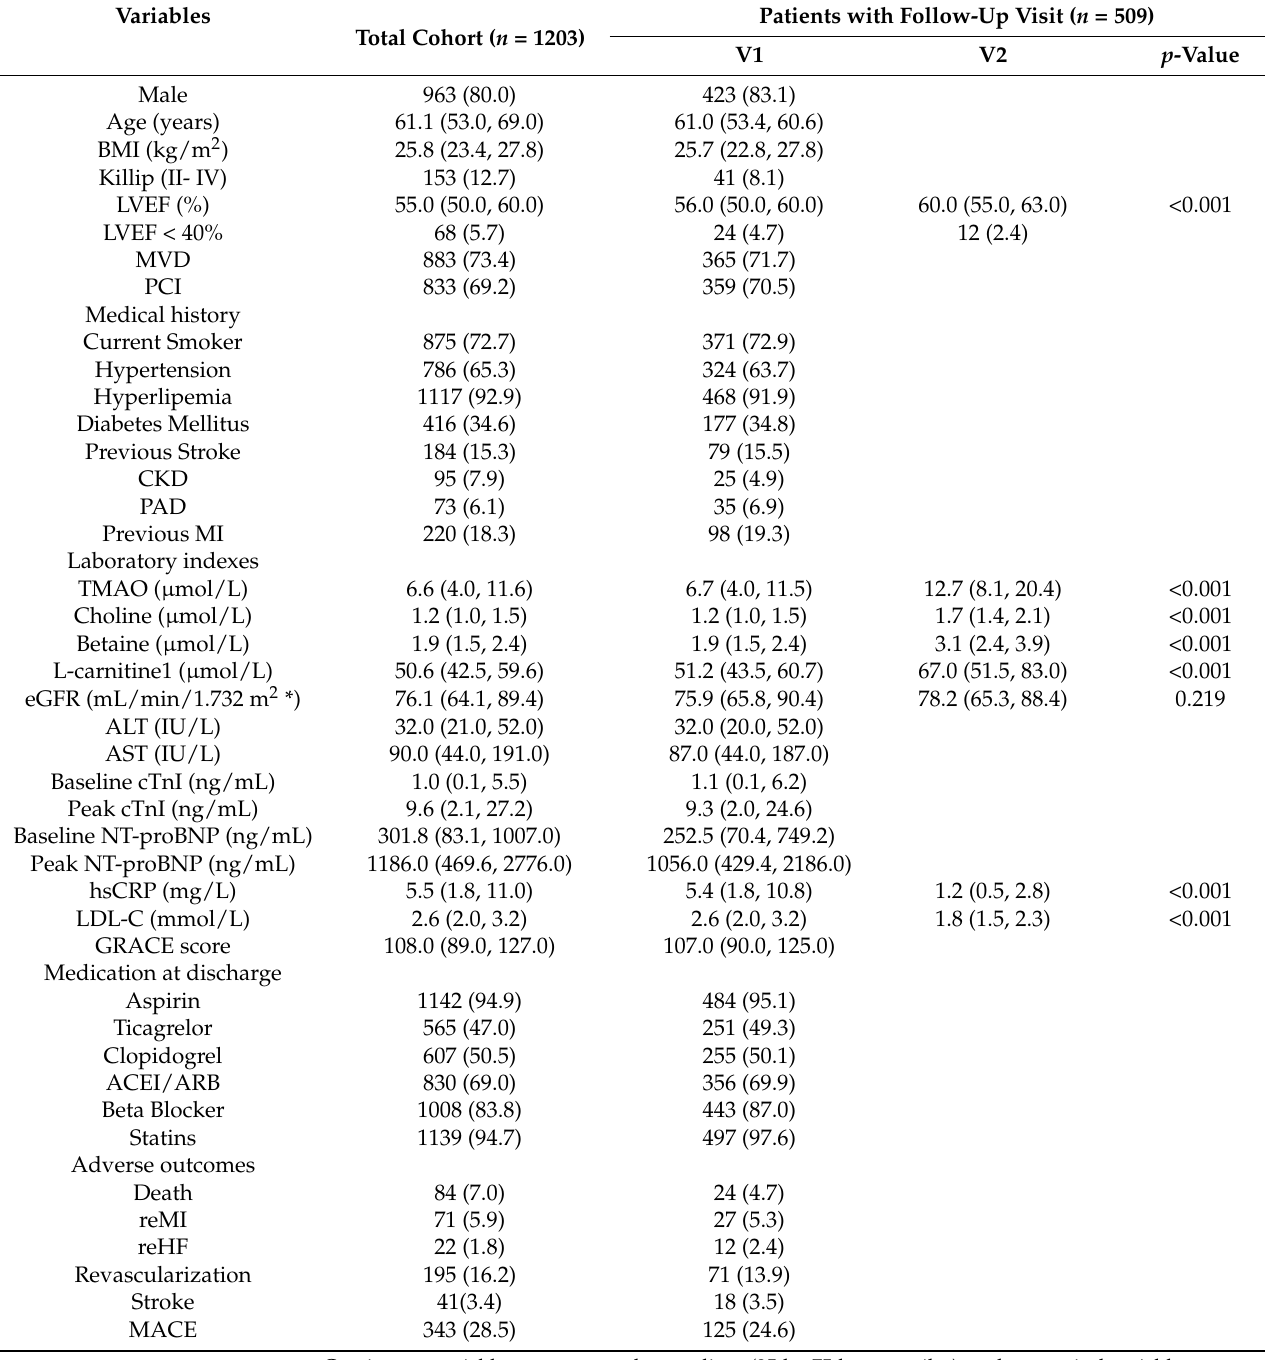
Table 1. The characteristics of included